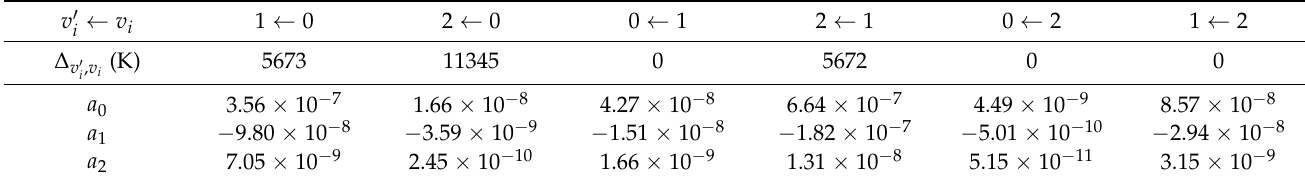
Table 4. Same as Table 2 for the asymmetric stretching mode of H 2